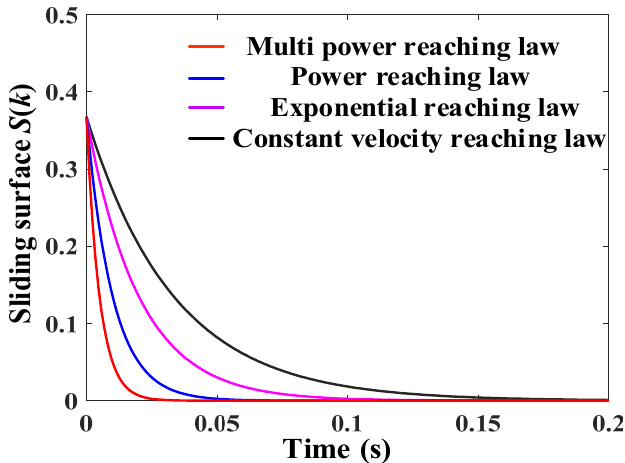
Figure 12. Reaching time at various reaching laws.